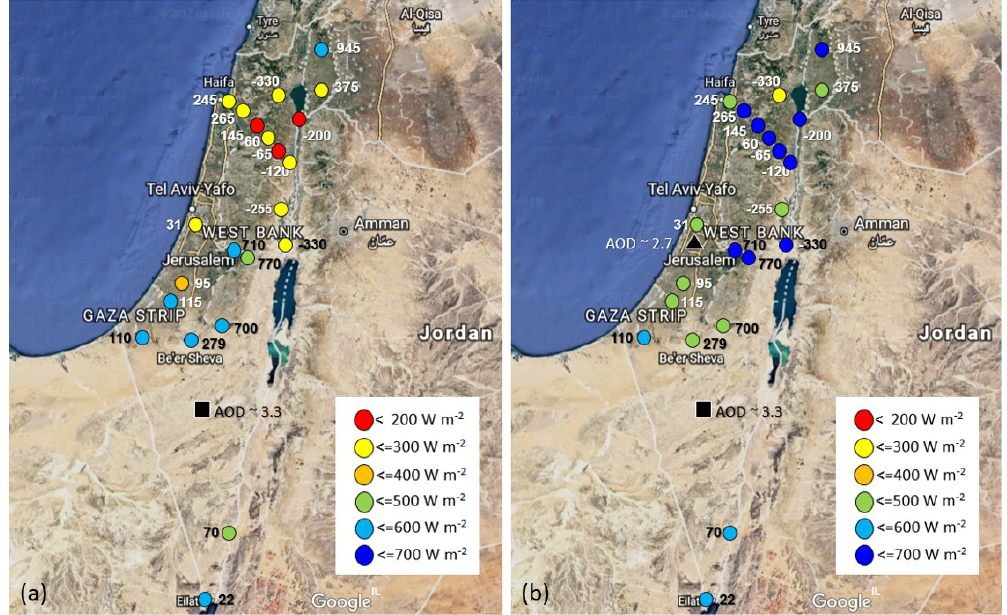
Figure 20. A map of maximum global solar radiation from 22 sites measured at 10:00UTC (midday) on 8 September 2015 (a) and 9 Septem- ber 2015 (b) . The map includes indications of the radiation range (see legend), height of measurement site (numbers on the map) and AOD from the AERONET Sde Boker site (black square) and Weizmann site (black triangle). On 8 September, AERONET at the Weizmann site did not operate due to power